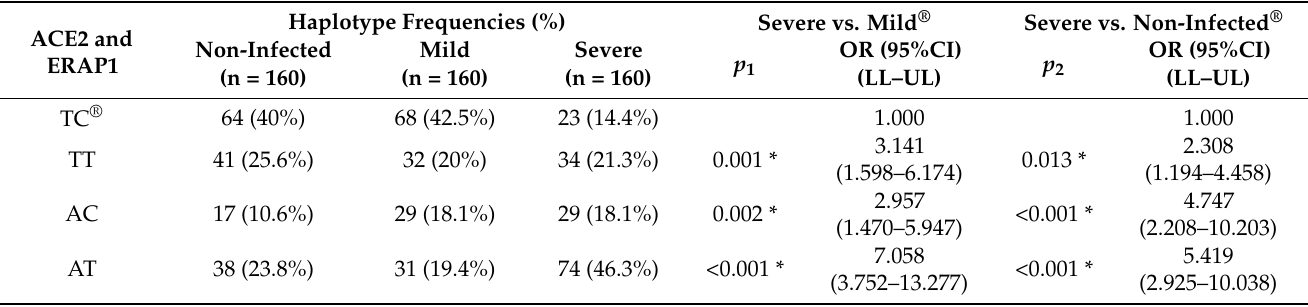
Table 5. Haplotype frequency for ACE2 and ERAP1 in the three study groups.